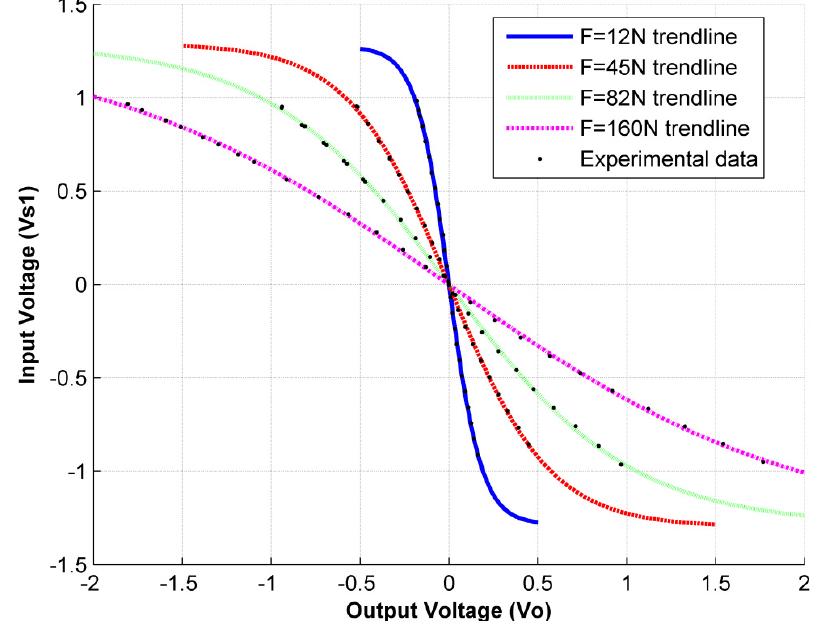
vs. V for the PFS for driving voltages below 1 V and four different exerted Figure 3. V s1 o forces of 12 N, 45 N, 82 N and 160 N. The trendline used for each individual fit was a hyperbolic tangent function [Equation